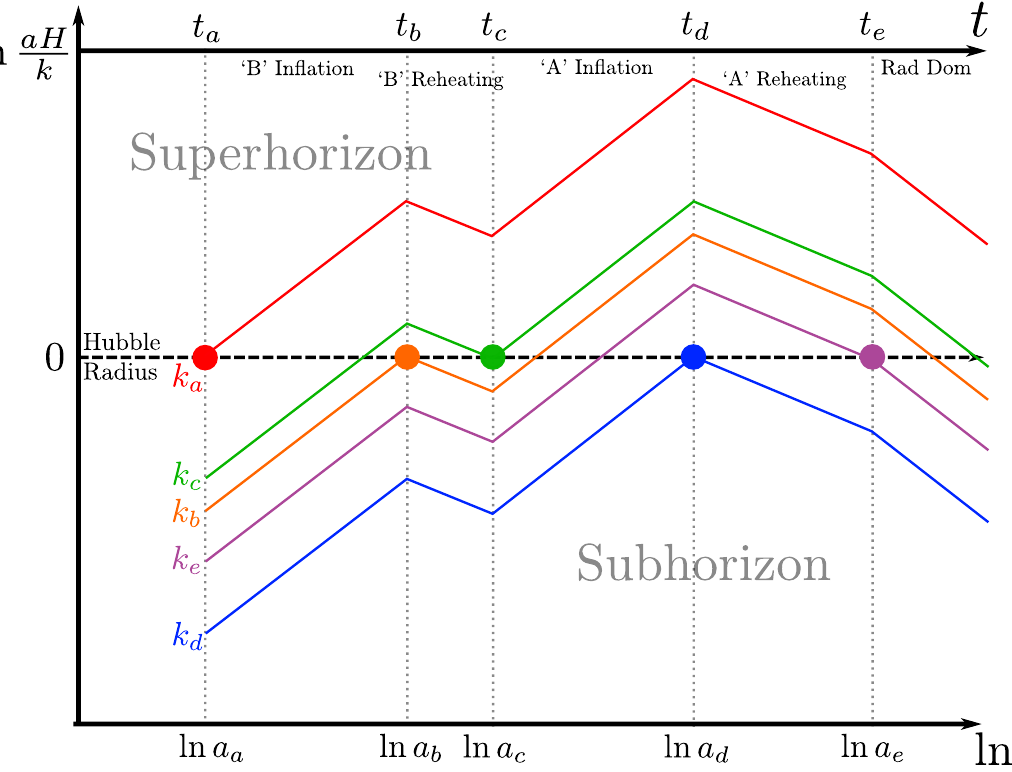
Figure 11 . Schematic evolution of the characteristic scales in Twin(cid:13)ation, as seen by comparing wavenumbers to the Hubble radius over time. Note that the time axis is not a linear